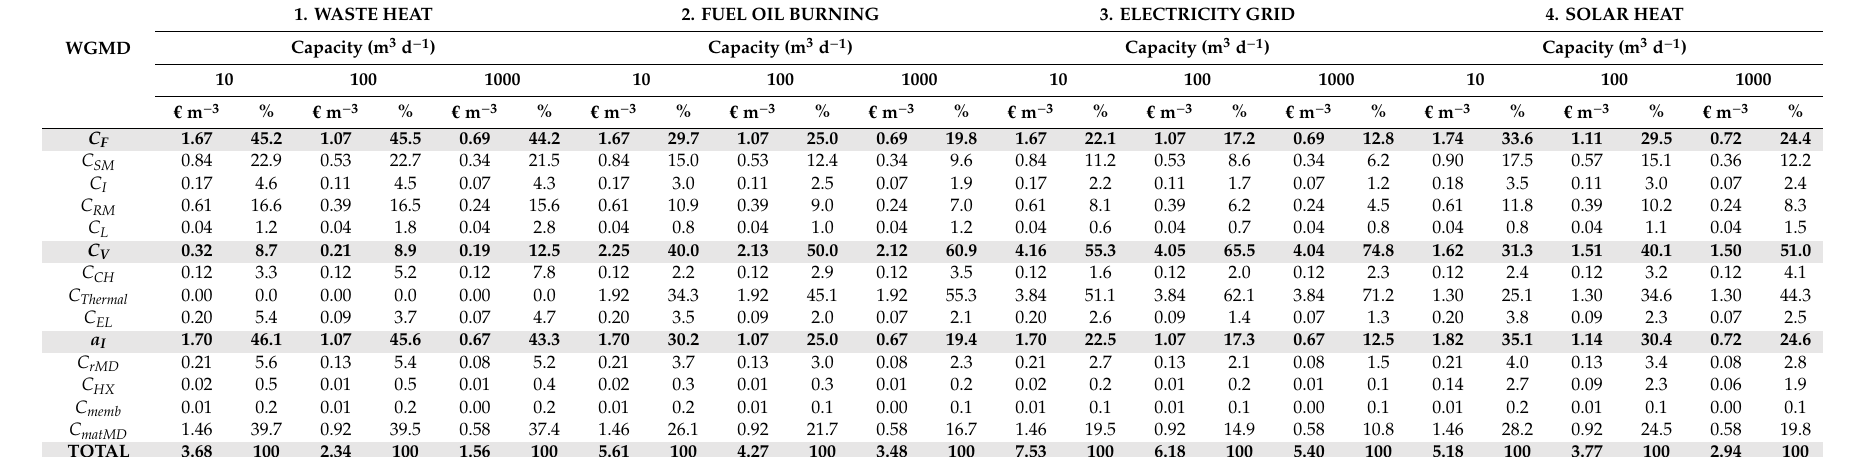
Table 4. Influence of the di ff erent WGMD costs on the SCOW. Costs are expressed in € m − 3 and % for each capacity and scenario considered.